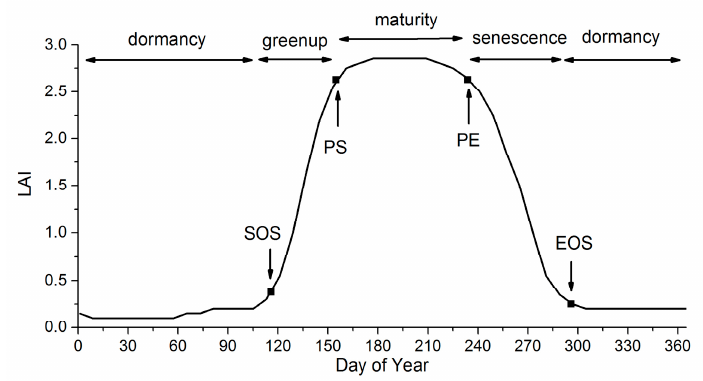
Figure 1. The phenological metrics of vegetation dynamics.